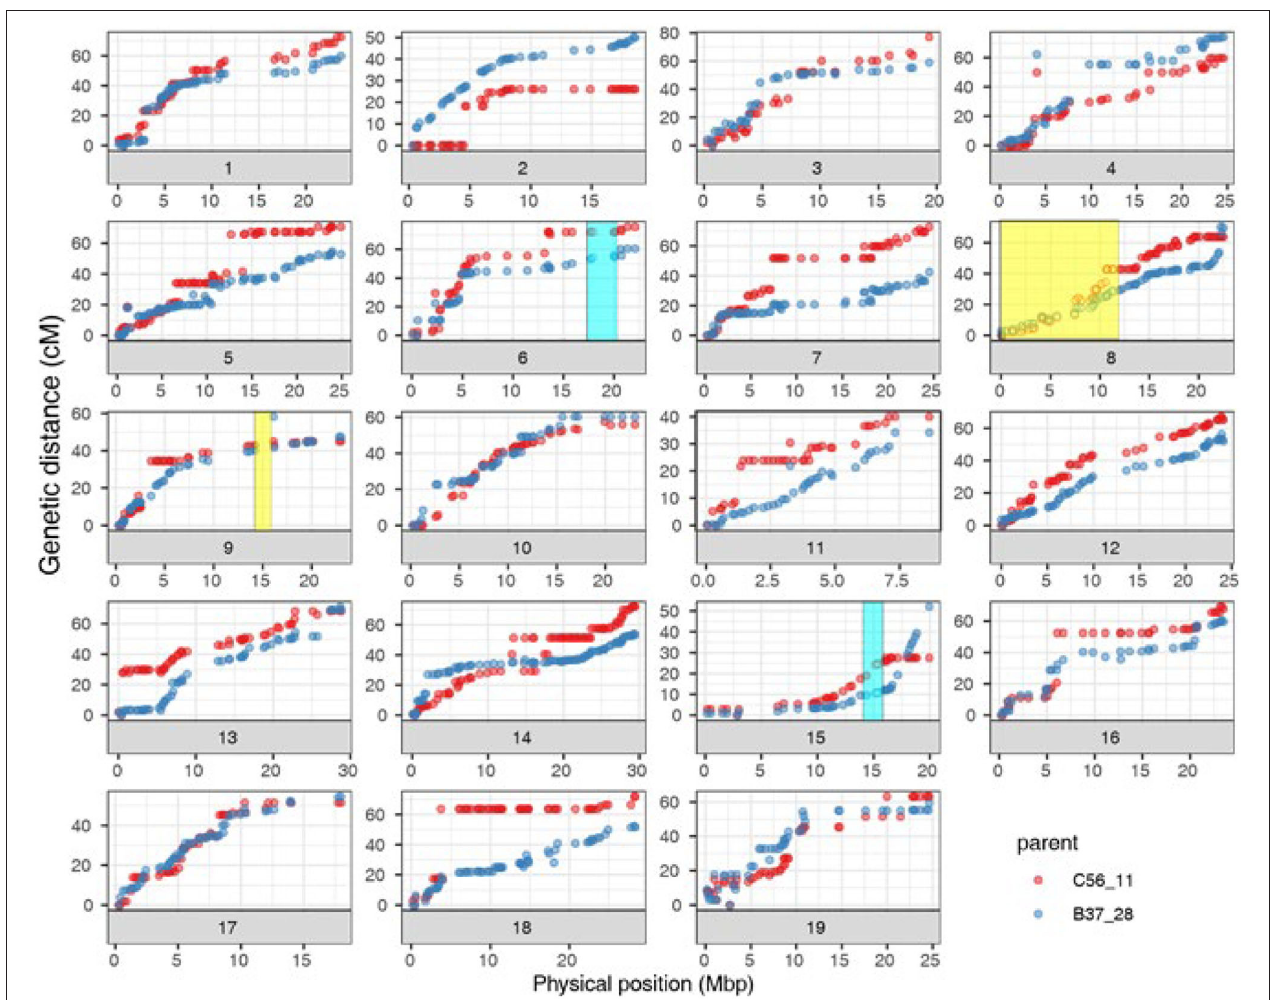
FIGURE 2 | Correlation of B37-28 × C56-11 parental genetic maps and PN40024 12X.v2 physical maps for the 19 chromosomes (Chr). Four quantitative trait loci (QTLs) that were found two or more times are shown as transparent boxes in yellow for stems (Chr 8 and 9) and blue for all four tissues (Chr 15) or all tissues except berries (Chr